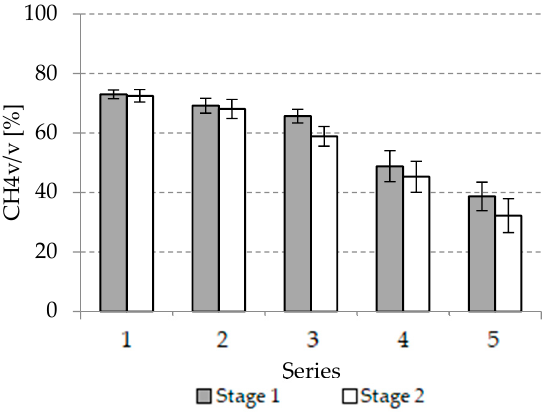
Figure 8. Methane fraction in the biogas.